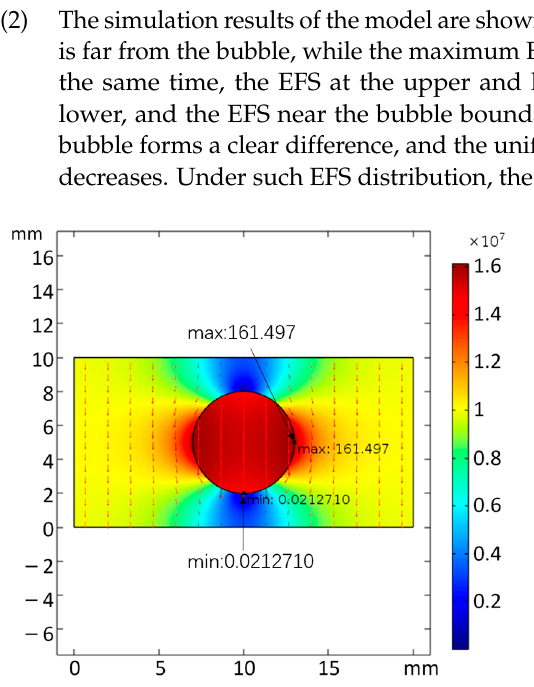
Figure 9. EFS distribution of rock under the influence of 3 mm—radius bubble.